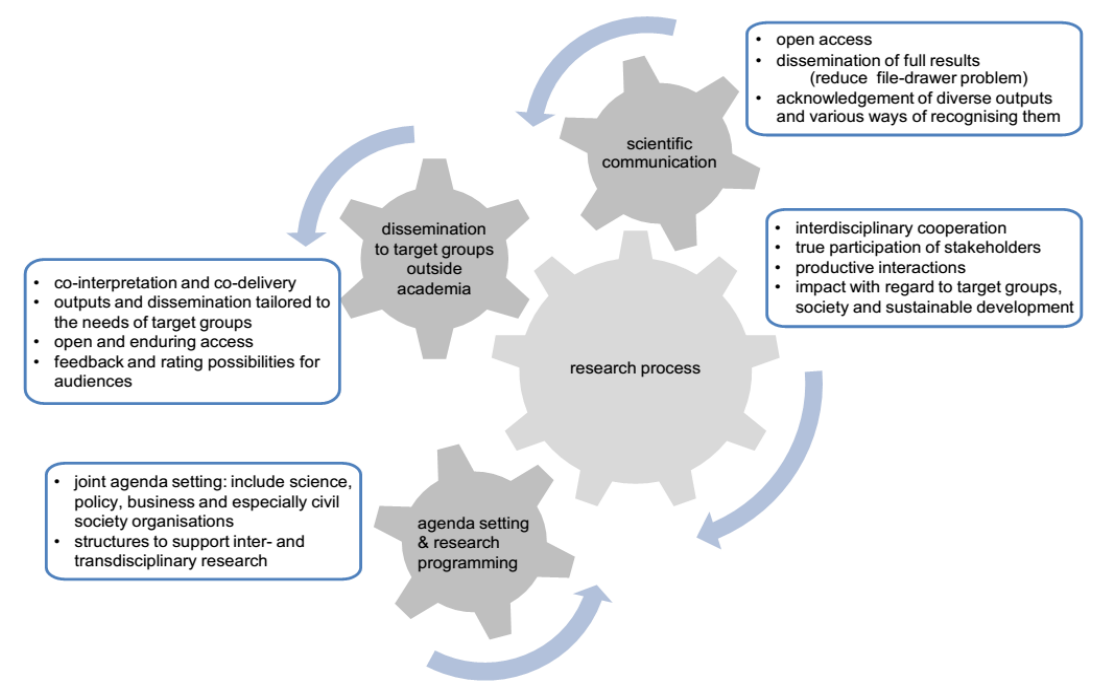
Figure 1. Possible criteria for evaluation beyond scientific impact regarding various aspects of knowledge